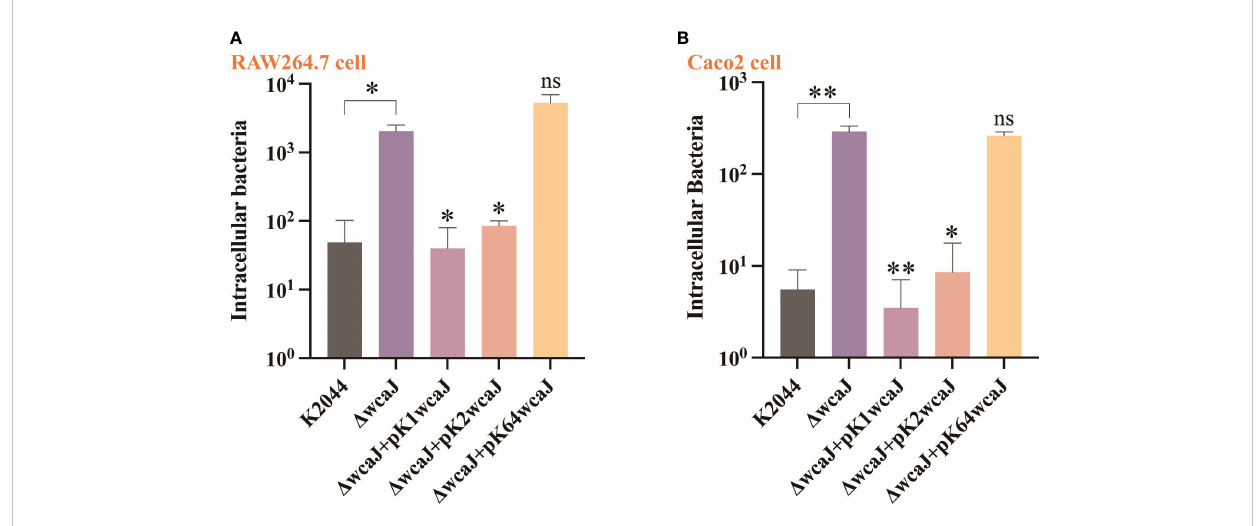
FIGURE 5 The cell internalization phenotypes of different Klebsiella pneumoniae mutants. The invasion assay was performed in (A) macrophage RAW 264.7 cells and (B) intestinal epithelial Caco2 cells. The K2044 D wcaJ strain was taken as a control group. Data were analyzed via one-way ANOVA. Each data point represents three replicates. ** P < 0.01, * P < 0.05, ns: not signi fi